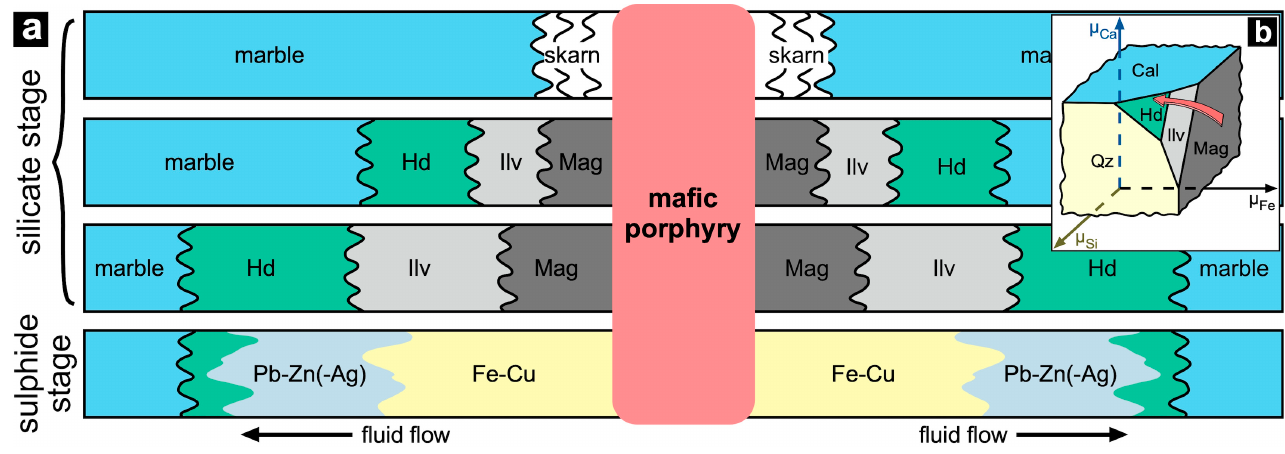
Figure 3. ( a ) Schematic illustration of the “classical model” of Campiglia skarn-forming event. Silicate stage is based on propagation reaction front model (modified from [36]) and mineralogical zoning [47]. Sulfide stage is based on [22] with spatio-temporal zoning of Fe-Cu sulfides (mainly pyrite, pyrrothite, and chalcopyrite) and Pb-Zn sulfides (sphalerite, and galena). ( b ) Chemical potential diagram for the Campiglia skarn (modified from [49]), based on Korzhinskii’s theory. Red arrow indicates the successive skarn zones from the source toward the marble host-rock.